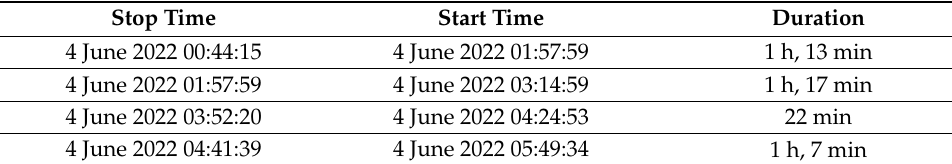
Figure 25. The evaluation of the performance of clustering algorithms on two-dimensional and three-dimensional AIS messages using the silhouette coefficient scores. Table 5. Information of the time that the vessel turned off its AIS system.